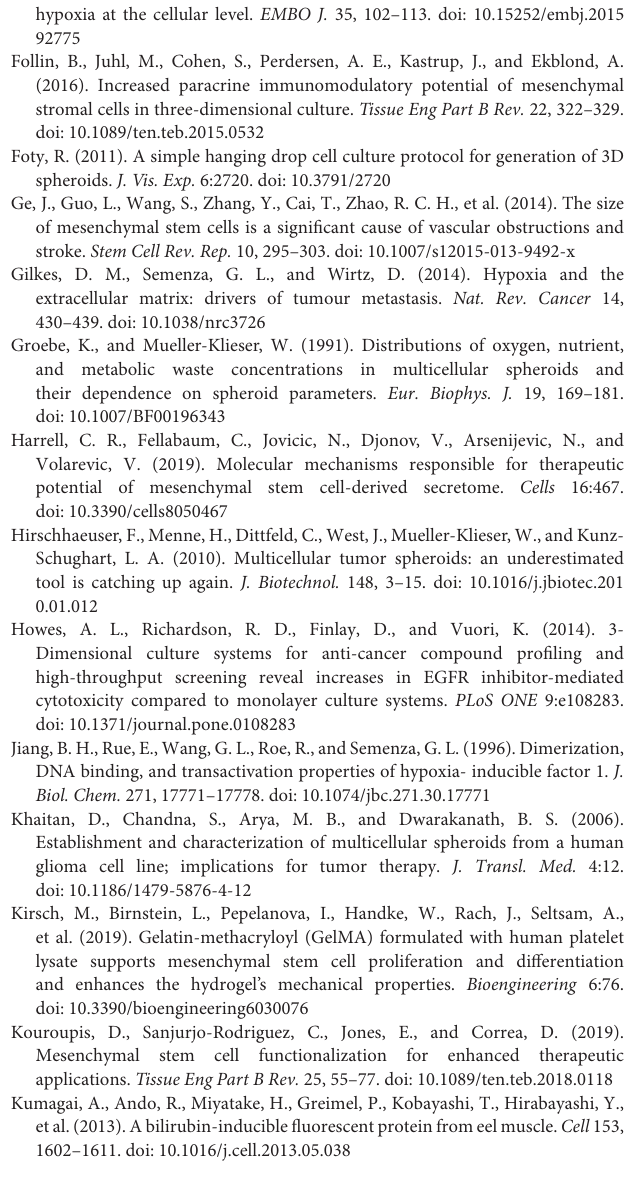
Supplementary Figure 1 | Flow cytometry analysis of surface antigens expressed by reporter MSCs (P9) after cultivation in 2D and prior to spheroid fabrication. Cells were stained with respective antibodies conjugated to fluorescent reporters. MSC typical antigens as CD 73 and CD 105 were expressed and cells were tested negatively for hematopoietic (CD34), leucocytic (CD45), and endothelial (CD31)